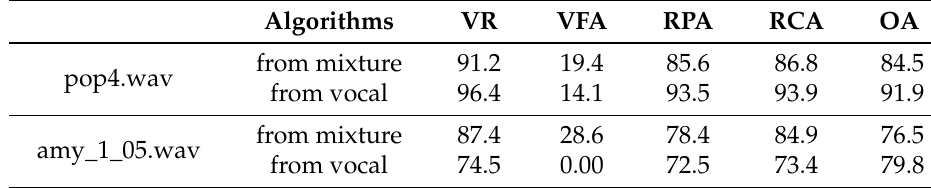
Figure 11. Bad example: “amy_1_05.wav” from MIR1k dataset. Table 7. Evaluation results of two